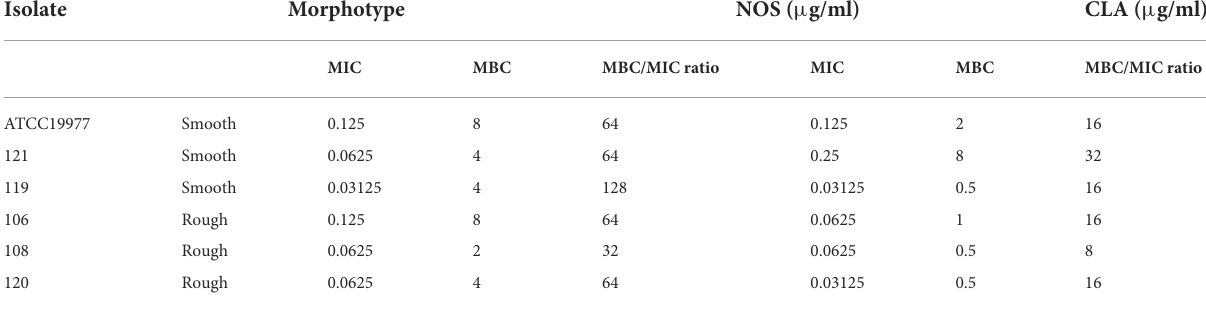
TABLE 2 Minimum inhibitory concentration (MIC), minimum bactericidal concentration (MBC) values, and antibacterial activities of NOS and clarithromycin (CLA) against Mycobacterium abscessus